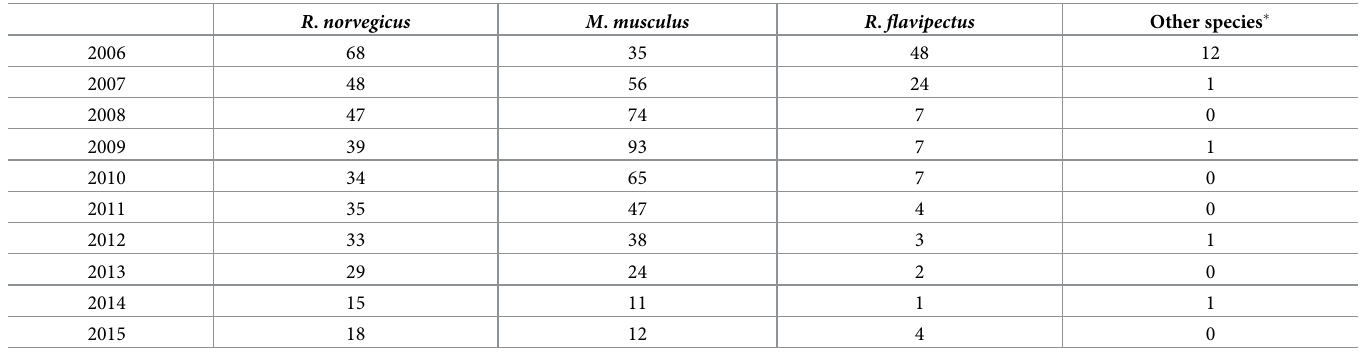
The potential contact β matrix and the environmental coefficient α matrix were visualized as shown in Fig 6, with low values colored in dark blue and high values in red. To unify the abscissas, the α matrix was transposed beforehand. The potential contact β matrix shows the relationships among the different land types, vari- ous rodent species, and HFRS occurrences (Fig 5A). The main risk of HFRS occurrence on cultivated land was from all types of rodents in these areas. The main risk of HFRS occurrence Table 1. Number of rodents of each species trapped in Chenzhou, 2006–2015. R . norvegicus M . musculus R .